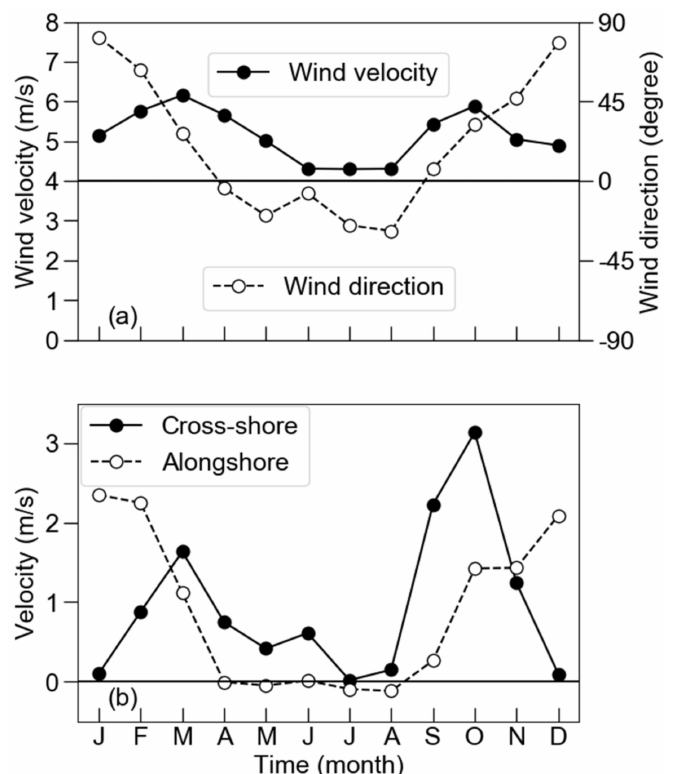
Figure 6. Monthly averaged wind characteristics: ( a ) absolute wind velocity and wind direction and ( b ) wind-velocity components in cross-shore and alongshore directions. The positive cross-shore and alongshore wind velocities are landward and southward,